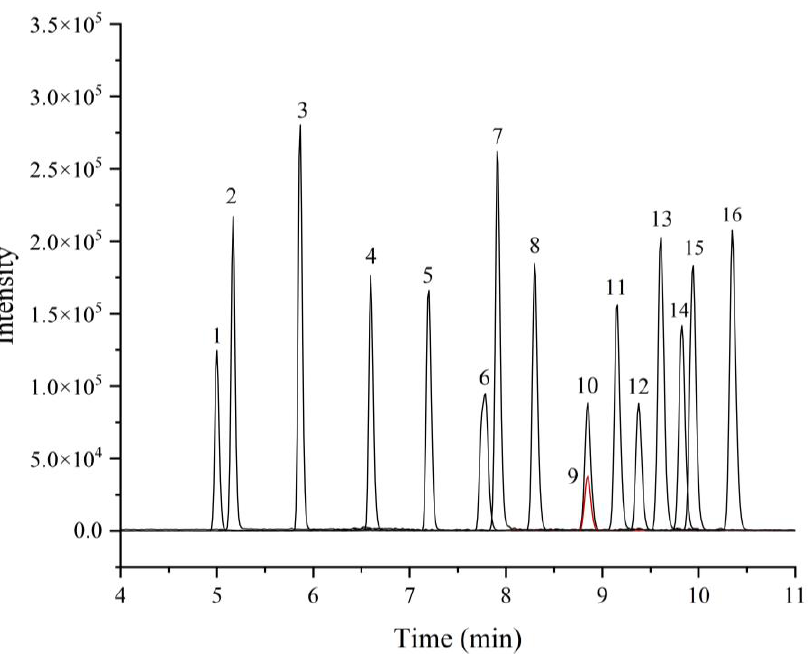
Figure 2. Ultrahigh-pe rformance liquid chromatogram of the mixed standard solution (10 μg/L). Peaks: 1, TEB; 2, SAL; 3, CIB; 4, RIT; 5, H-CLB; 6, RAC; 7, CLO; 8, CLB; 9, PEA; 10, FOM; 11, TUL; 12, BRM; 13, MAB; 14, CLP; 15, ISS; 16, BAM. Although the two substances of PEA and FOM have the same peak time on chromatography, they can be further separated by mass spectrometry.